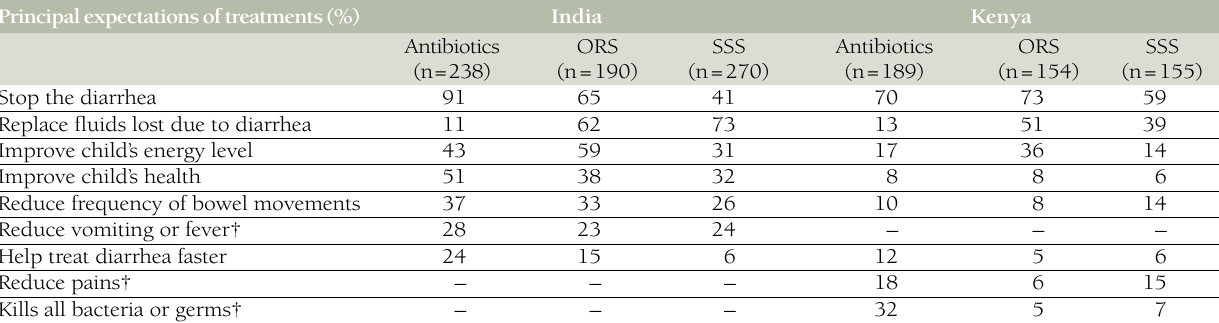
Table 2. Expectations (% respondents) of main treatments, when used to treat at last episode of diarrhea Principal expectations of treatments (%) India